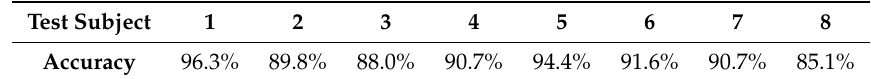
Table 4. k-fold validation on